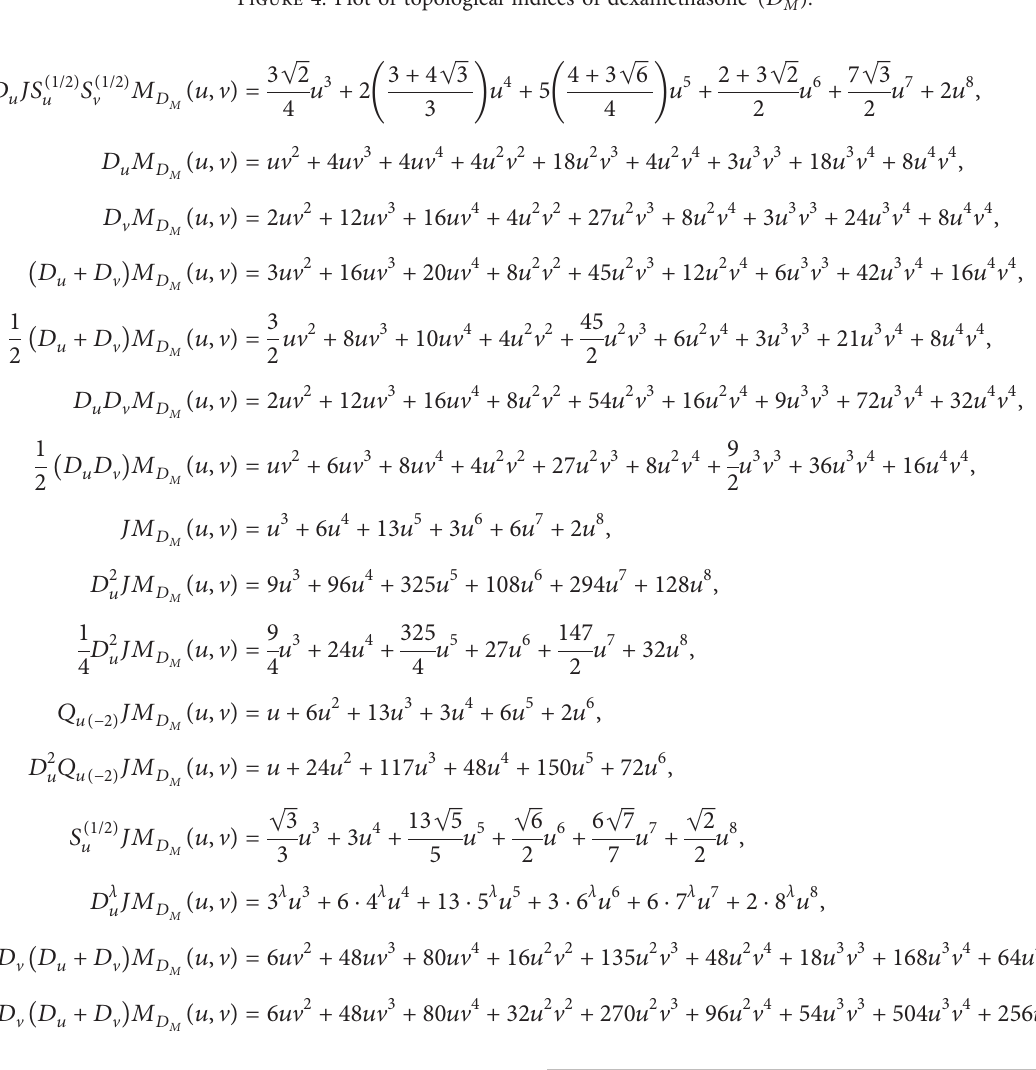
Figure 4: Plot of topological indices of dexamethasone ( D